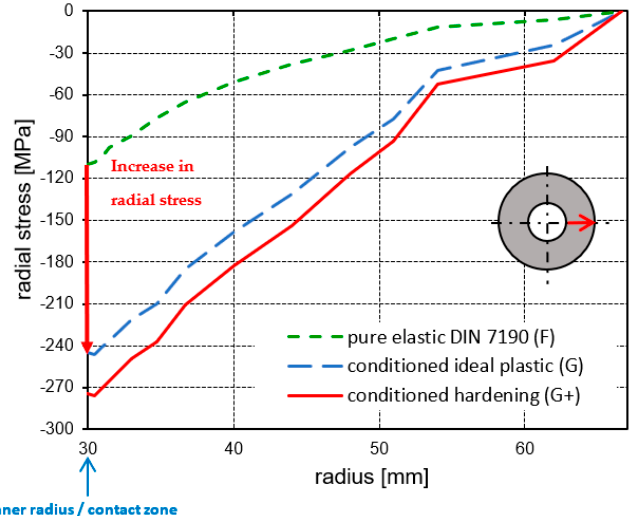
Figure 5. Radial stresses in the stress states of the points F elast , G , and G + with a safety against plastic deformation of the outer part S PA = 1.5 = S + PA ( S + PA → after hardening of the material).